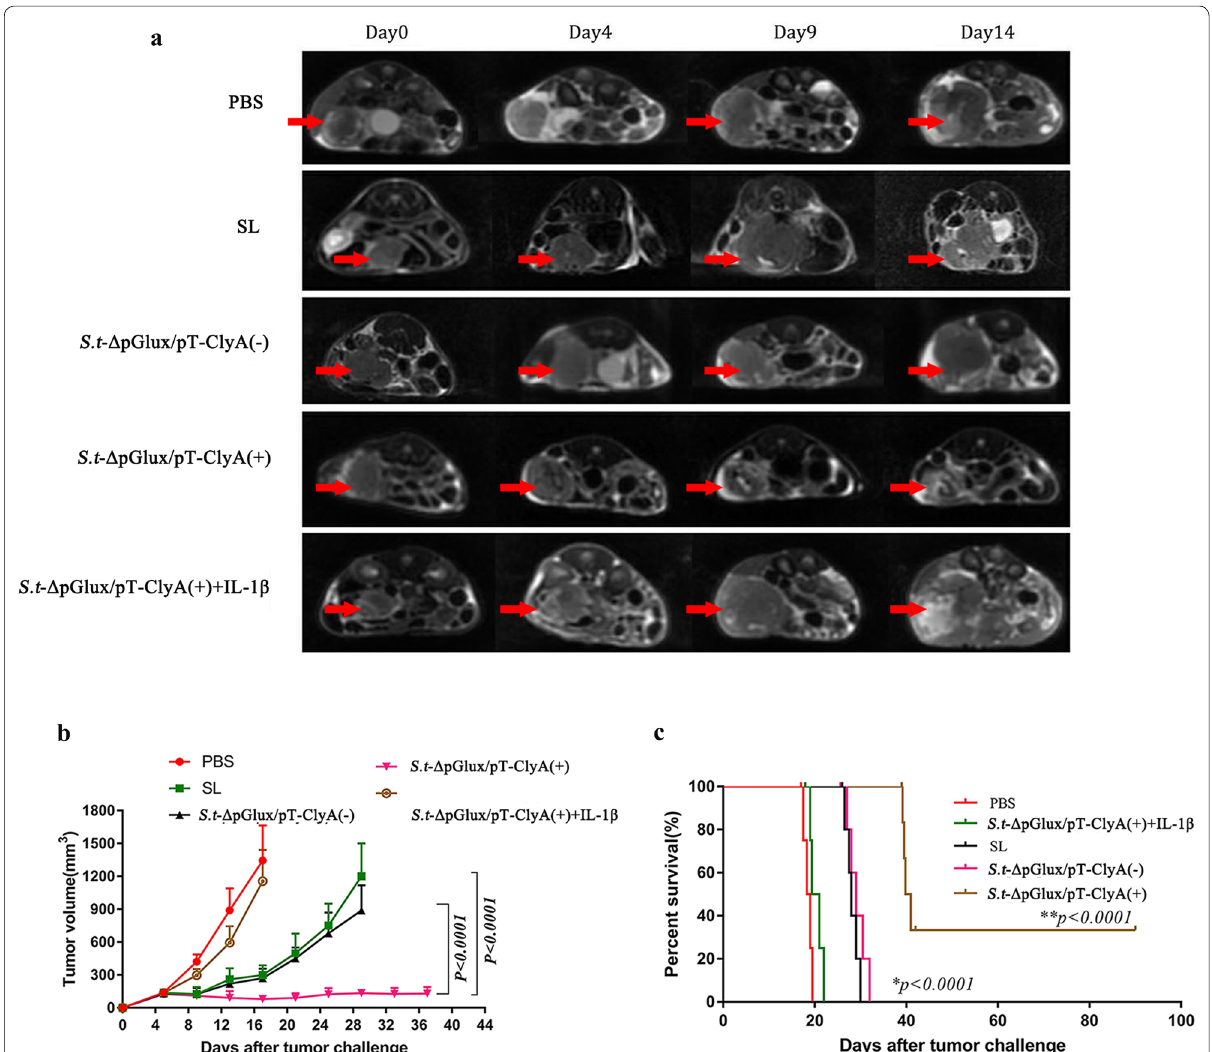
Fig. 3 Effect of engineered lux/pT-ClyA-expressing Salmonella on growth and survival of CT26 tumors. BALB/c mice (n surgically implanted with one piece of CT26 tumor in the ceca colon. When tumors reached a volume of approximately 120–180 mm 3 , mice were divided into five treatment groups. Groups received intravenous (i.v.) injections of PBS, ΔppGpp S. typhimurium , or ΔppGpp S. typhimurium carrying lux/pT-ClyA either with ( ) or without ( ) doxycycline induction. For IL-1β depletion, mice received an i.v. injection of anti-IL-1β-specific antibody + − (IL-1β Ab) 1 day before engineered Salmonella typhimurium secreting lux/pT-ClyA (Day 1). The antibody was then injected twice a week for 2 weeks. Where relevant, mice received 17 mg/kg/day doxycycline. a Images of tumors from representative mice from each group. b Changes in tumor size. c Kaplan–Meier survival curves for CT26 tumor-bearing mice. Statistical significance was calculated by comparison with PBS or S.t -ΔpG lux/ pT-ClyA( + ) +